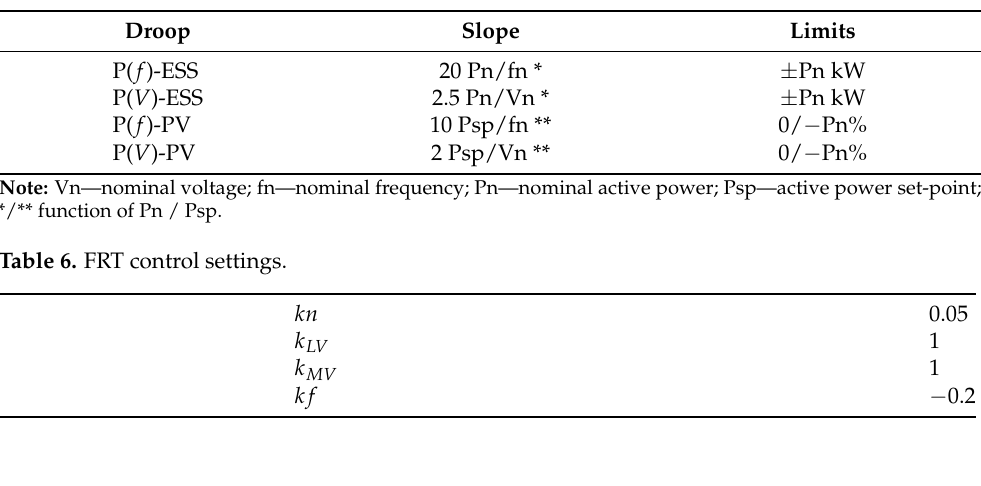
Table 7. Using a commercially available solution [42] as reference (see Table 7), the required capacitance was determined according to Equation (26) for the following assumptions: A